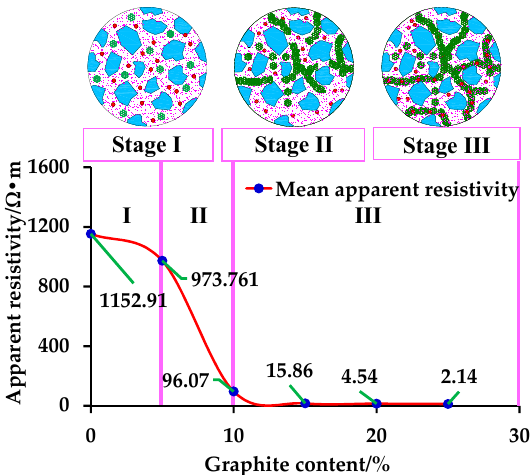
Figure 10. Unstressed material internal structure and apparent resistivity versus graphite content.